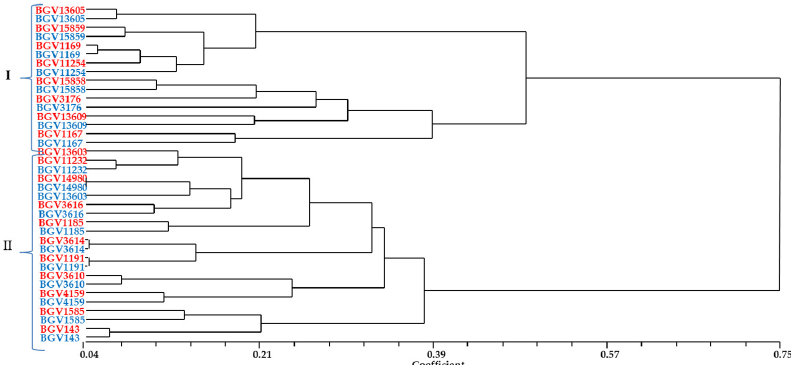
Figure 5. Scatter plot of the PCA scores. In red, scores of spring trial; in blue, autumn trial. Yellow to greenish-yellow seeds ( − ), maroon seeds ( ◊ ), grey, brownish to greenish seeds (-), black seeds ( □ ), brown, pale to dark seeds ( Δ ), whitish seeds ( Ο ). Accessions included in the yellow and green areas correspond to the ones included in the two main clusters in Figure 6.